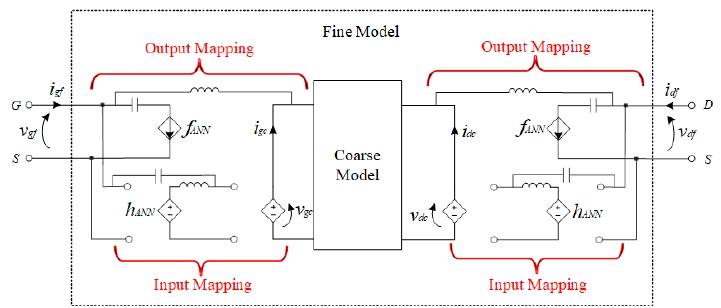
Figure 1. Circuit-based structure of the separated model.